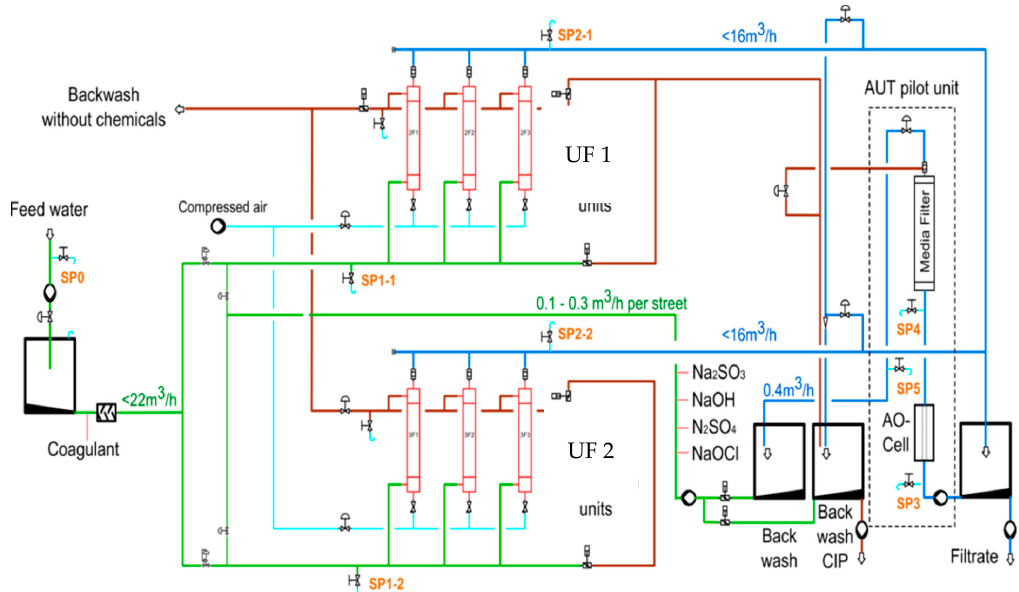
Figure 4. A flowsheet of the ultrafiltration membrane unit in combination with the AUTARCON electro-chlorination ECl 2 system (AUT) inline electrolysis unit. CIP, clean-in-place.